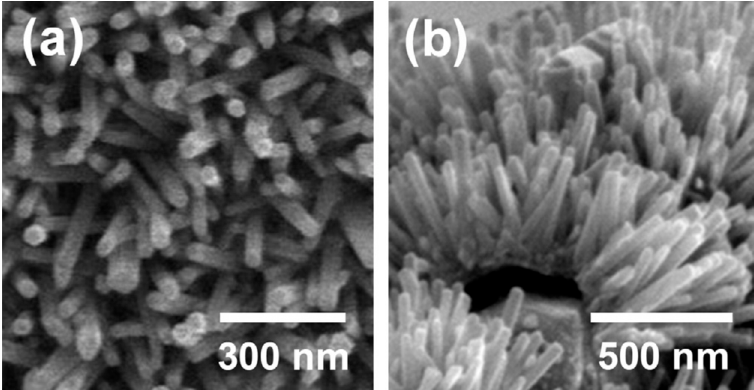
Figure 3. ( a ) Top view and ( b ) oblique view of SEM images of ZnO nanorod arrays [37].